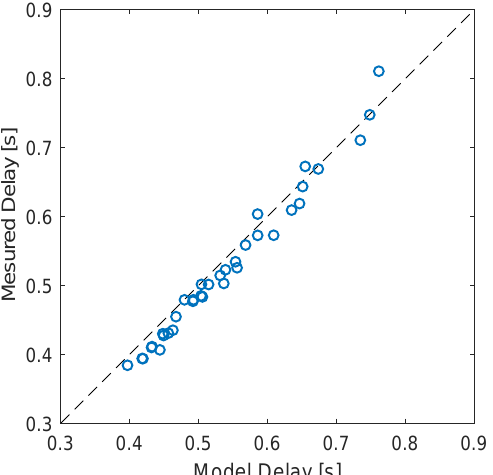
Figure 26. Comparison between the delay obtained cross-correlating the signal of the camera and WMS (measured delay), previously shown in Figure 18, and the delay estimated based on the conservation of mass (model described in Appendix B). The perfect match between the model and experiments is represented by the dashed